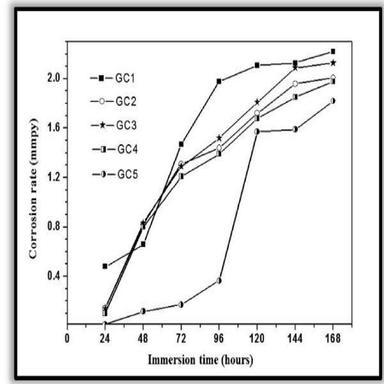
Variation in corrosion rate against time for hybrid geopolymeric material coated samples in 3.5% NaCl.